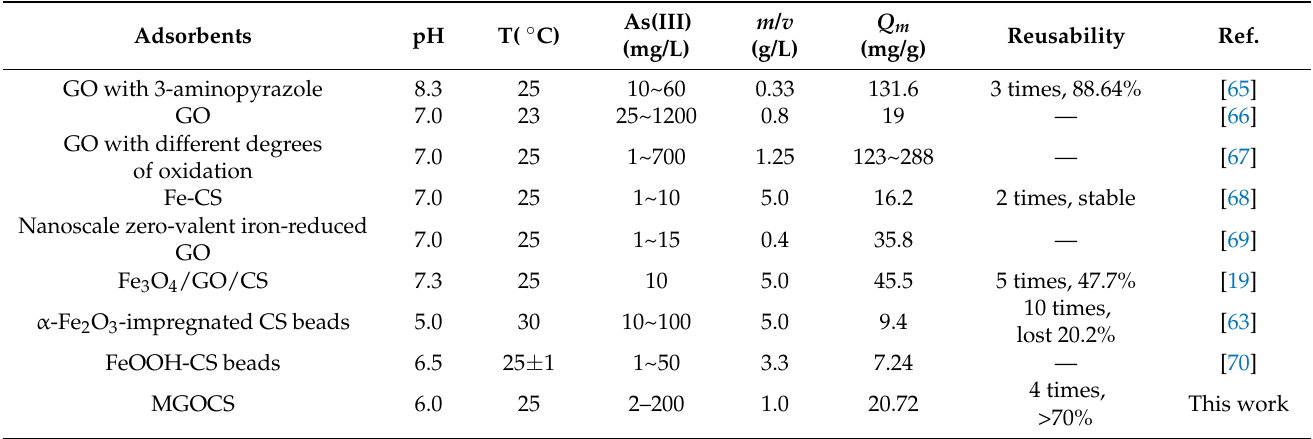
Figure 15. Changes in the removal efficiency ( R e ) of MGOCS over four times of regeneration. Table 3. Comparison of As(III) removal by MGOCS and other similar